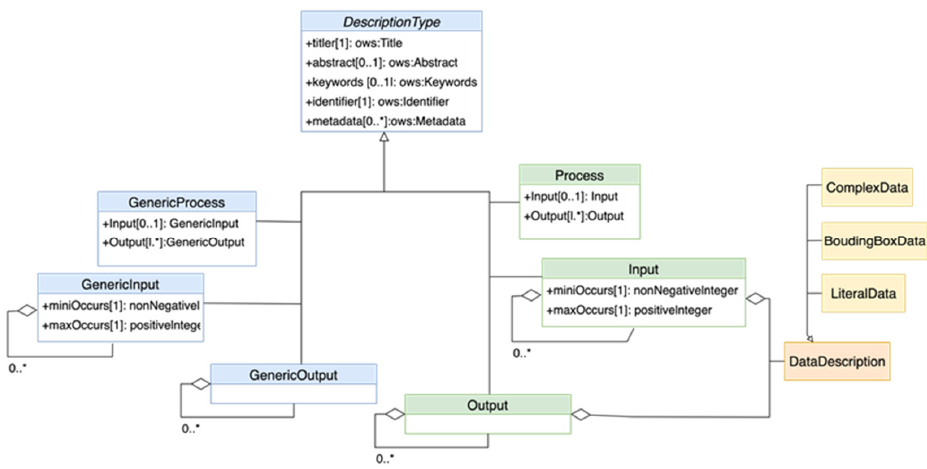
Figure 4. Generic process profile and process description using UML diagram.